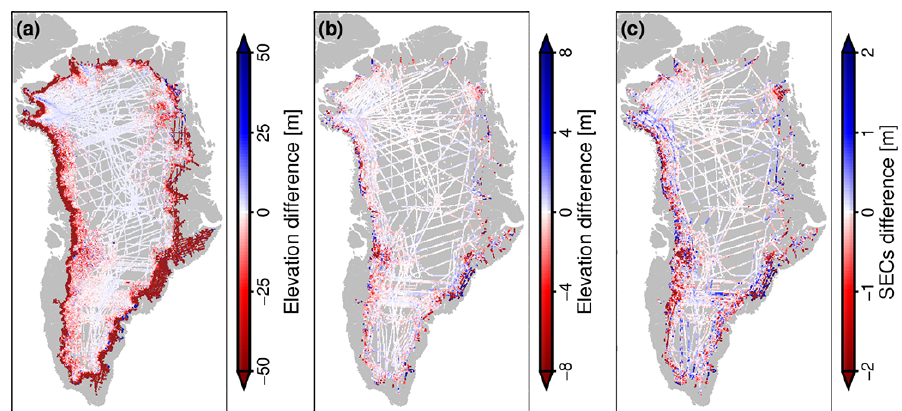
Figure 10. Validation with ATM laser altimeter observations: (a) differences between SE derived from ATM L2 and our merged time series, (b) differences between SE derived from ATM L4 and our merged time series, and (c) differences between SEC derived from ATM L4 and our merged time